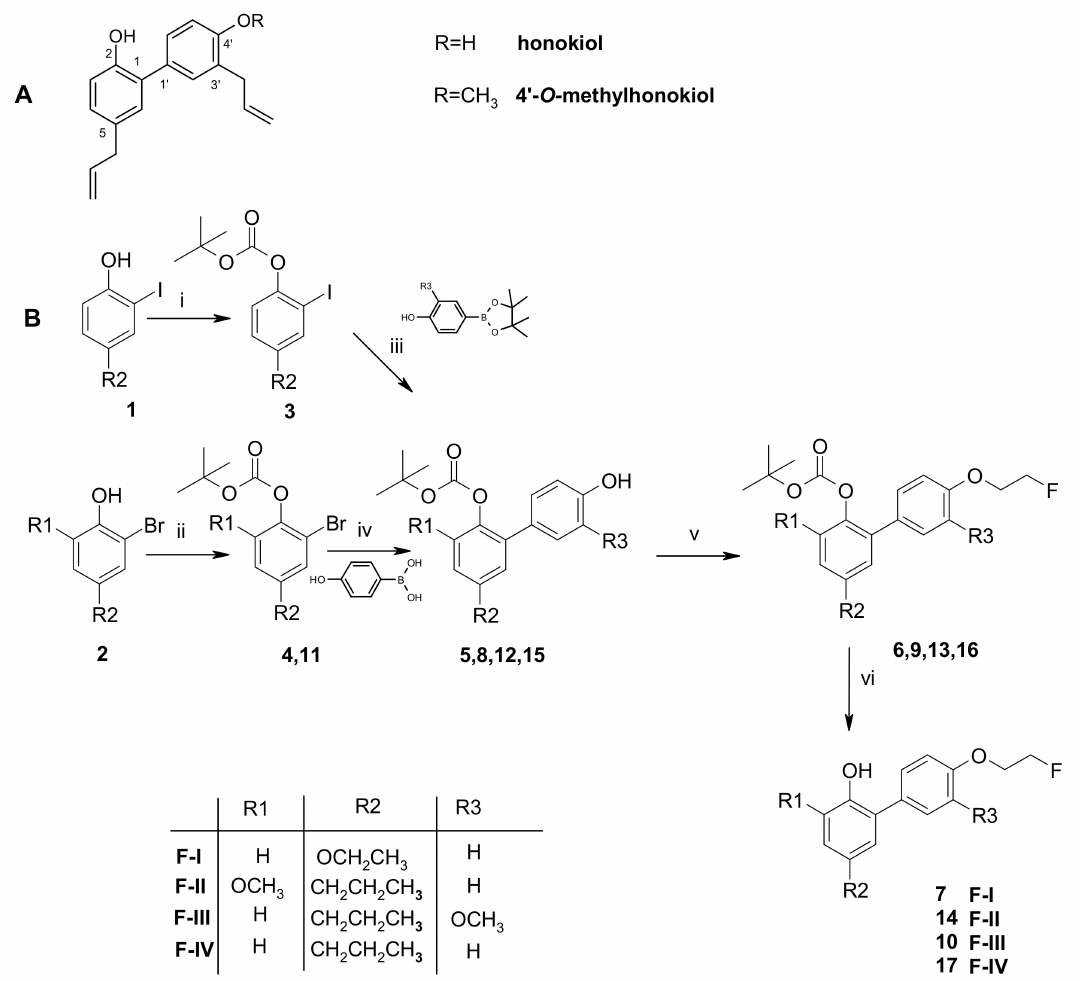
Scheme 1. ( A ) Structures of neolignans honokiol and 4 (cid:48) - O -methylhonokiol (MH). ( B ) Syntheses of F-I–F-IV derivatives. Reagents and conditions: (i) and (ii)—Boc 2 O, DMAP, DCM, 20 ◦ C, 17 h; (iii) and (iv)—Pd(Ph 3 P) 4 , Na 2 CO 3 ,